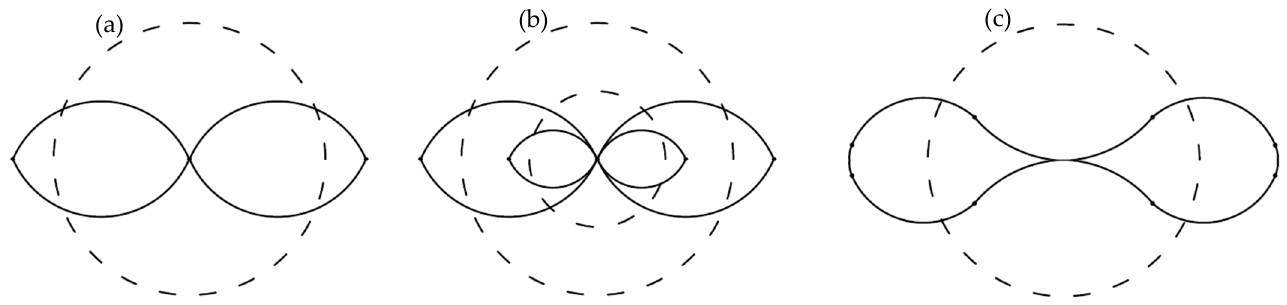
Figure 1. Buckle propagation mode in the 2D scenario: ( a ) single-walled pipe, ( b ) PIP, and ( c ) single- walled pipe.